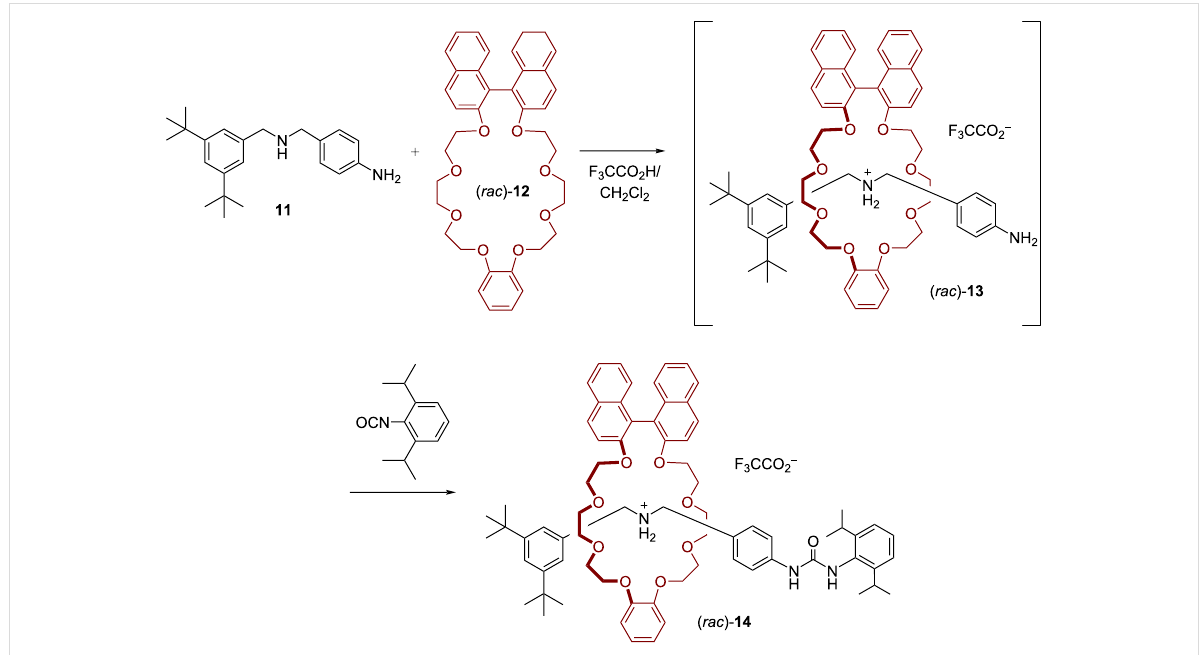
Figure 4: Synthesis of Stoddart´s [2]rotaxane ( rac )- 14 by an ammonium crown ether template.